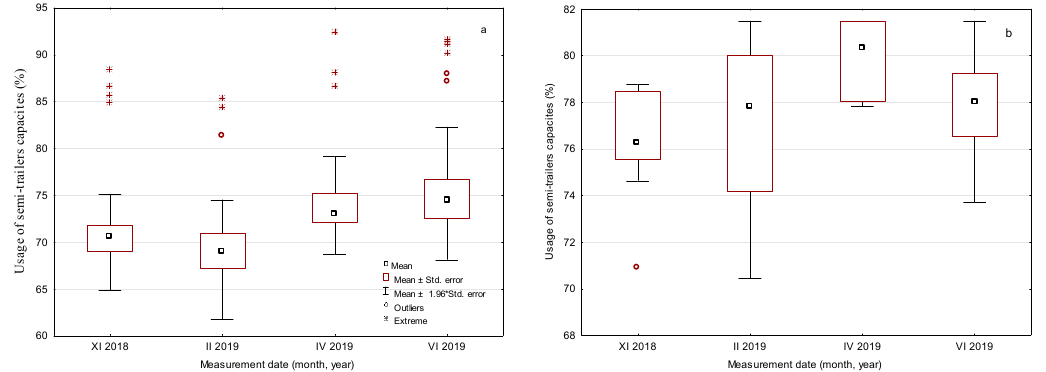
Figure 7. Comparison usage of semi-trailers capacities by measurement date for unit A wood chips ( a ); sawdust ( b ).